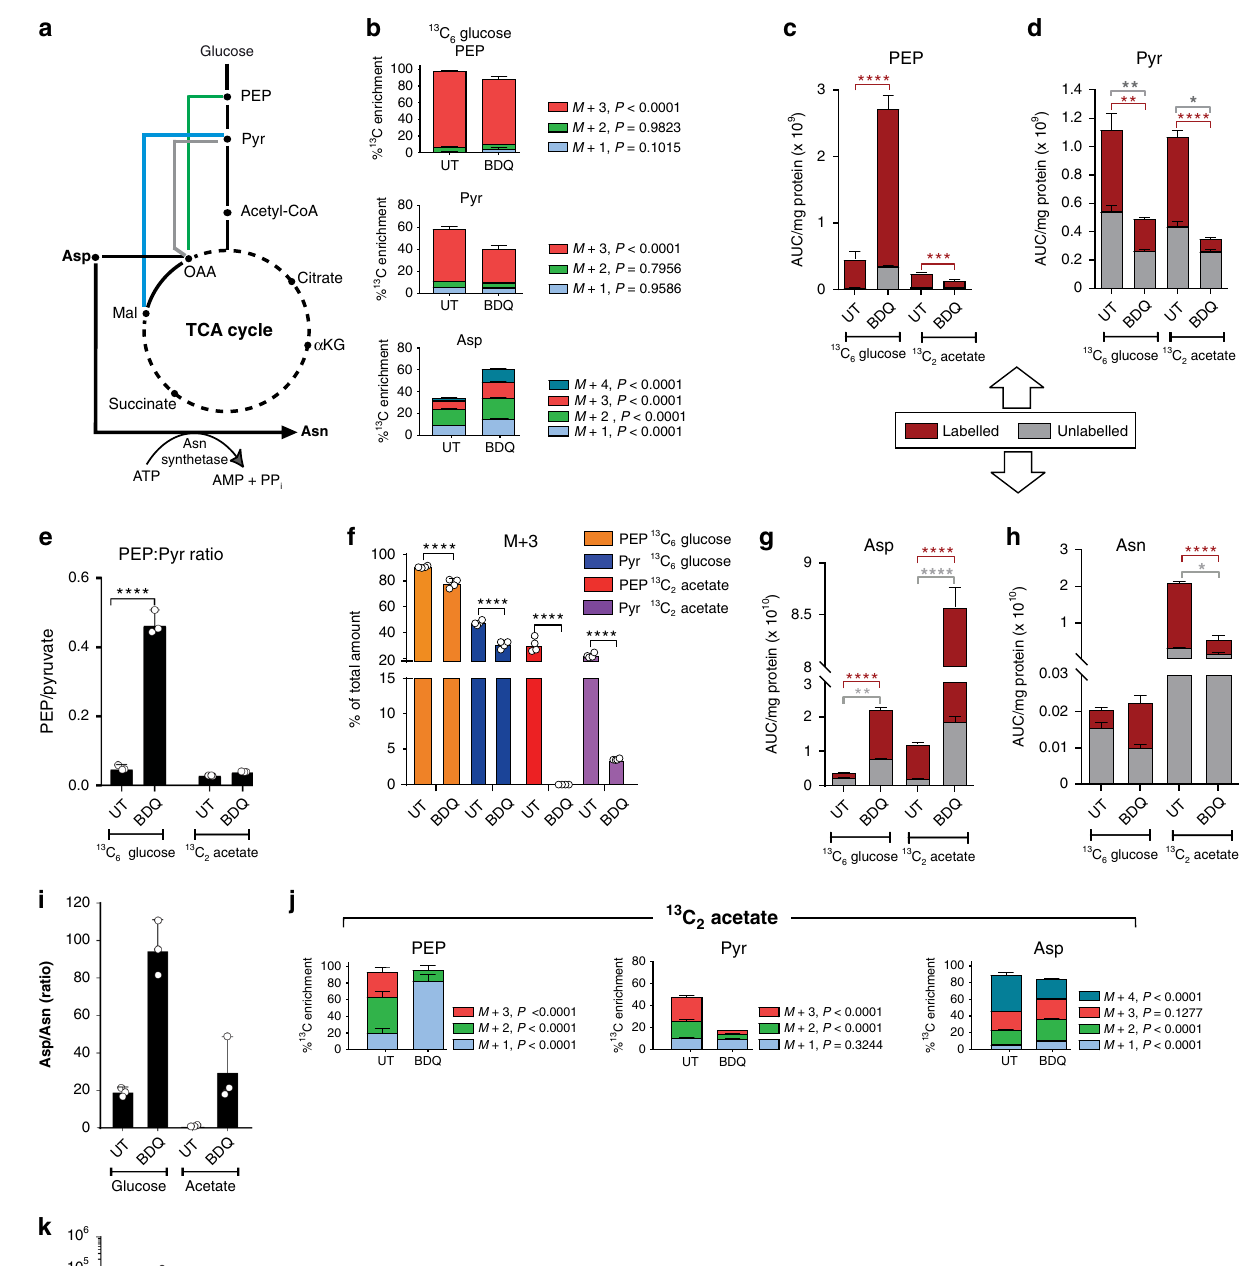
TCA cycle following conversion to oxaloacetate or acetyl-CoA (Fig. 2a). However, during gluconeogenesis, PYR and PEP are formed from oxaloacetate or malate and PEP can be formed directly from PYR 25 (Fig. 2a). Thus, PEP and PYR play a vital role in gluconeogenesis as the direct precursors for glucose formation 23 . To further examine BDQ ’ s effect on PEP and PYR metabolism, we used 13 C 6 glucose and 13 C 2 acetate as carbon